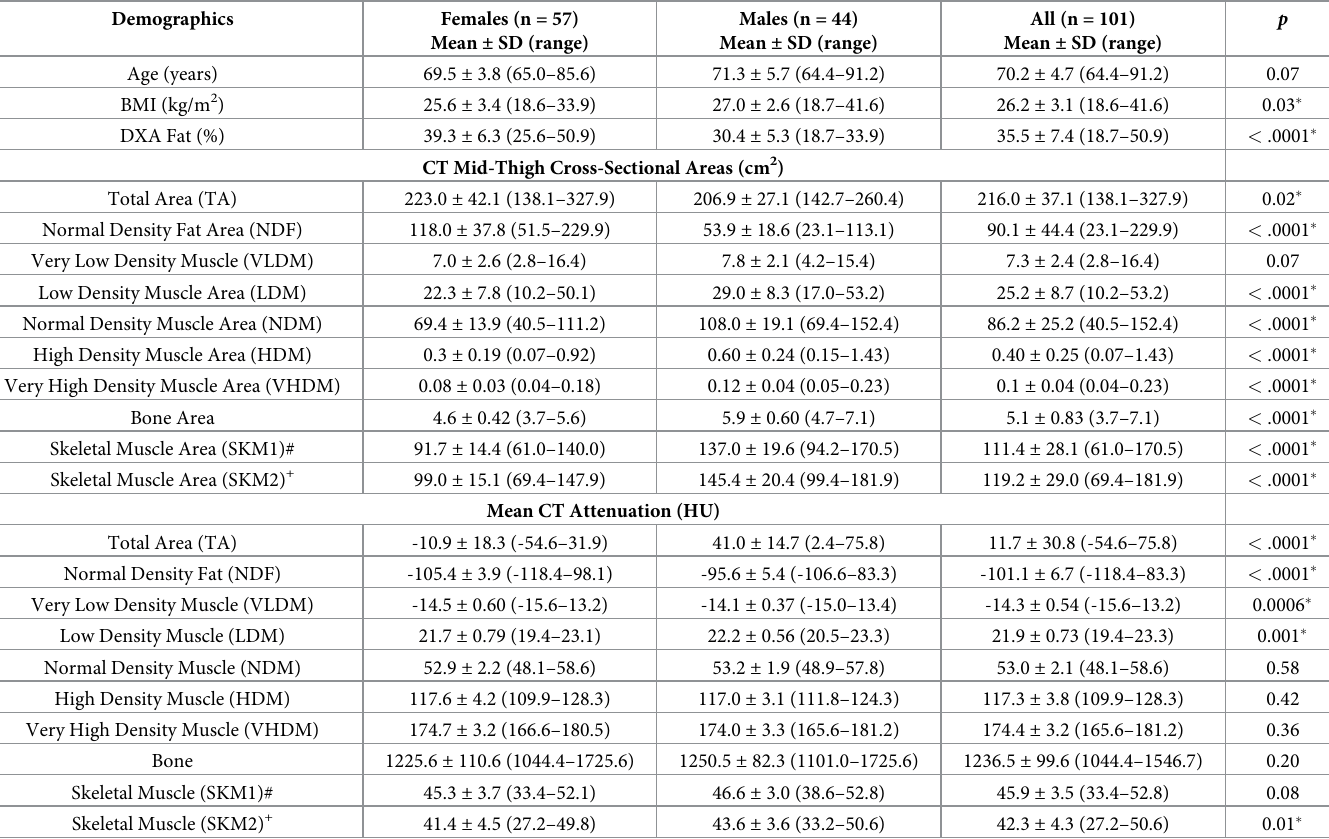
Table 1. Baseline demographics and computed tomography characteristics of study